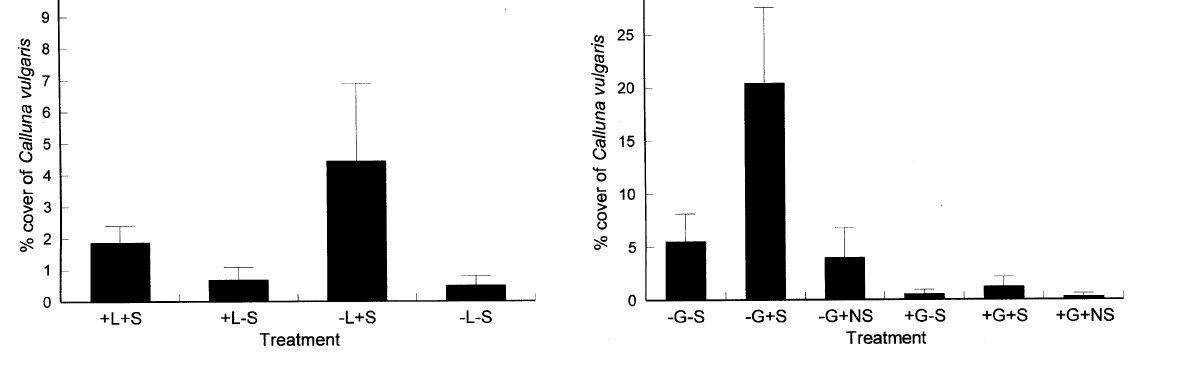
Fig. 4. The effects of grazing exclusion (–G), seed addition of Calluna vulgaris (+S), and addition of a nurse crop seed ( Des- champsia flexuosa , +NS) on the mean cover ( ± 1 SE, n = 16) of C. vulgaris five years after treatment at Wetherhouse